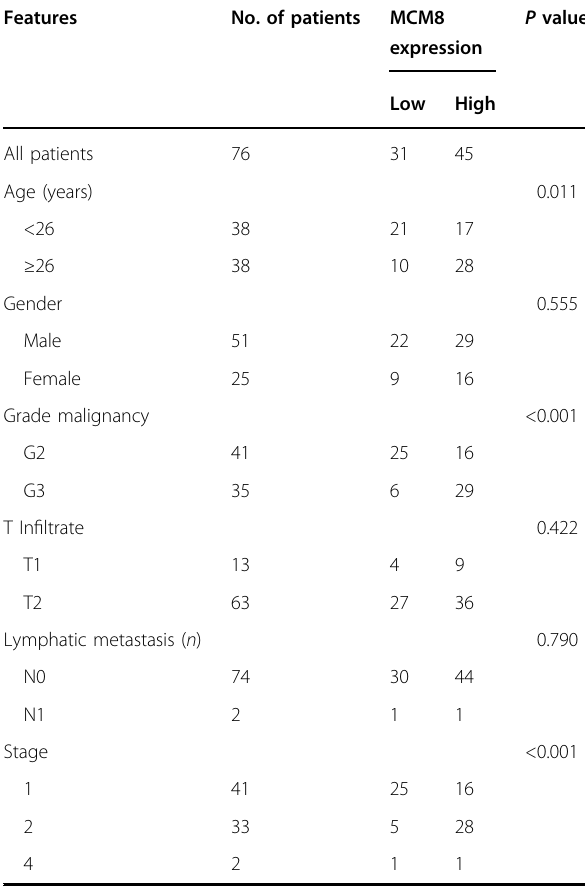
Table 2 Relationship between MCM8 expression and tumor characteristics in patients with osteosarcoma.